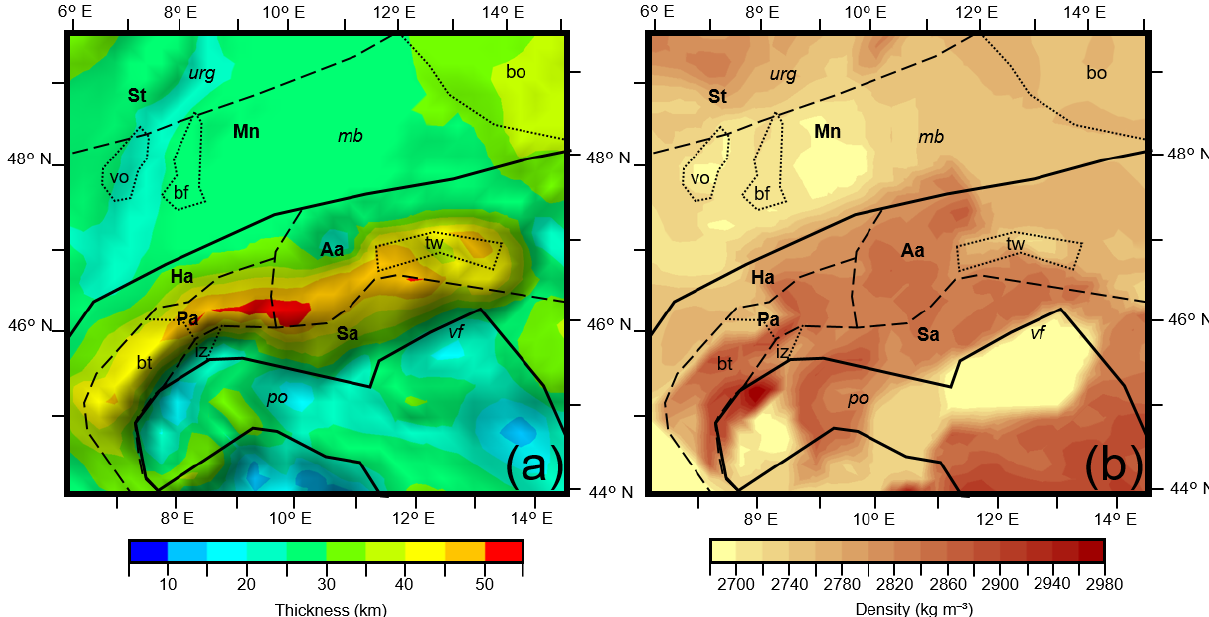
Figure 7. (a) Thickness and (b) average density of the entire crust across the modelled area. Solid lines demark the boundaries of Alpine zones; the dotted black lines indicate the extent of the non-accreted Adriatic plate. Locations of key tectonic features are overlaid (definitions shown in Fig. 1a